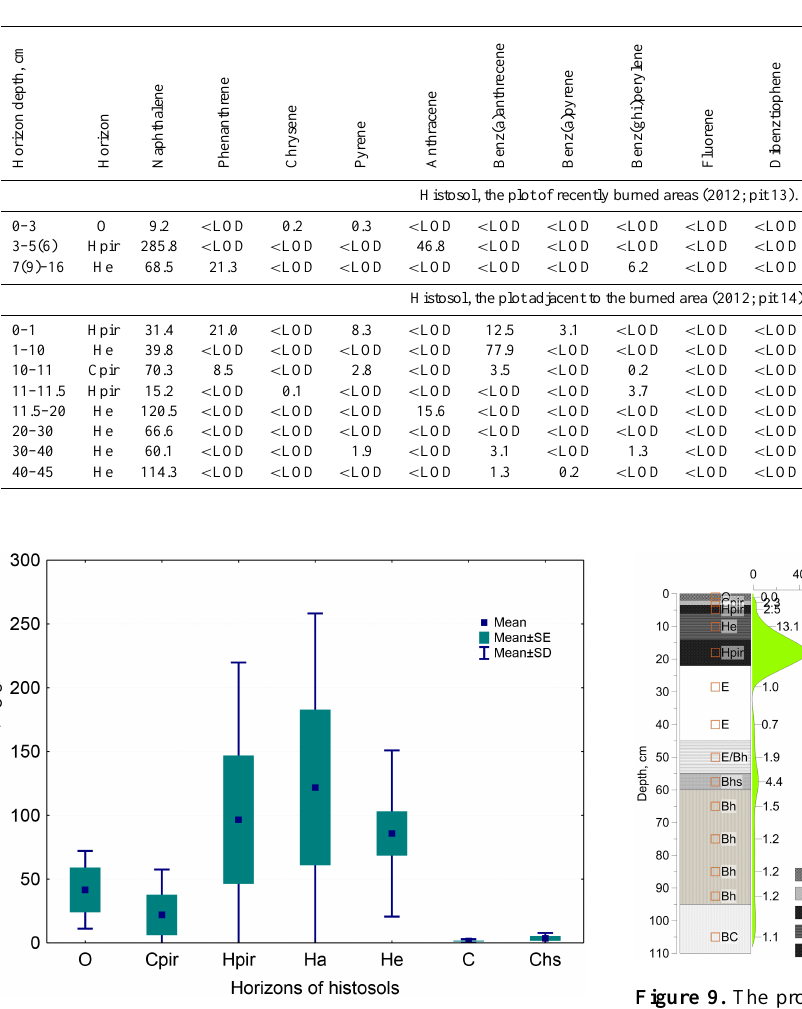
Figure 8. The categorized box and whisker plot for total PAHs in different horizons of histosols (pits 7, 8, and 9). The number of sam- ple replicates: O-3, Cpir-5, Hpir-6, He-14, Ha-5, Chs-5, and C-12. Horizons Cs and Ch were combined for this analysis, indicated by Chs.